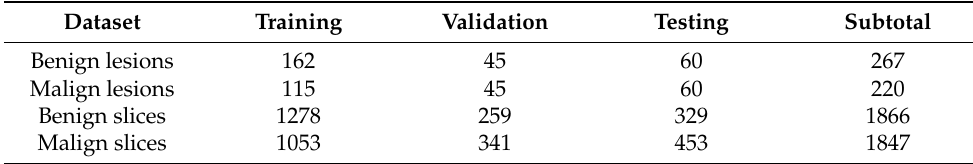
Table 2. Dataset split.